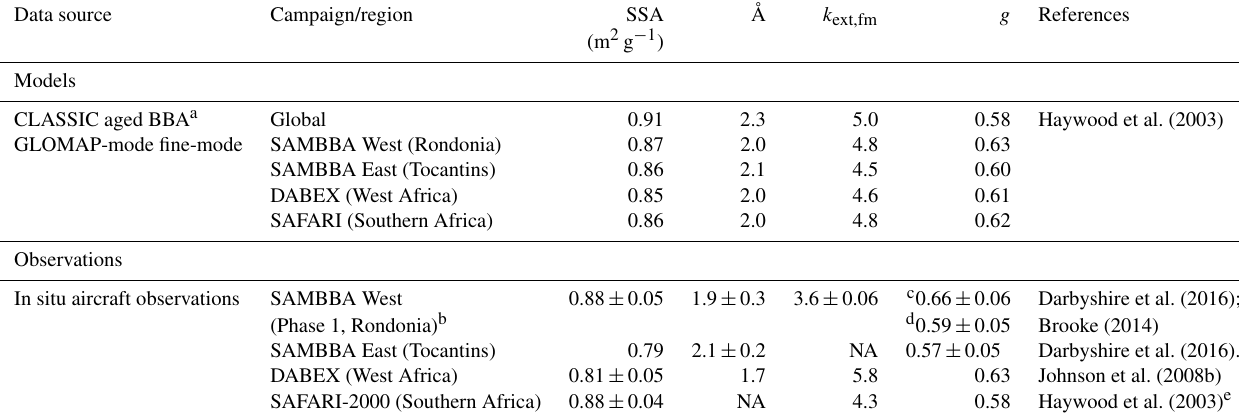
Table 2. Dry aerosol optical properties at 550nm from model and observations including single scattering albedo (SSA), the Ångström exponent (Å), the fine-mode specific extinction coefficient ( k ext,fm ) , and asymmetry parameter ( g ). Error bounds are given to observed parameters, where available, to reflect uncertainty in the measurement.